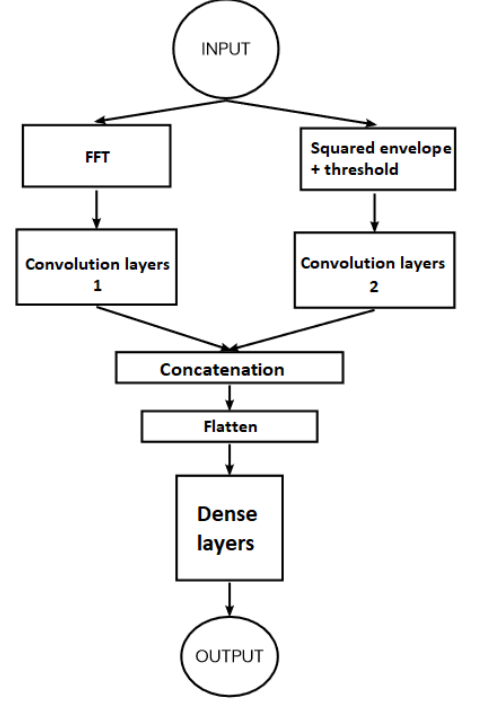
Figure 14. Structure of the DICNN.